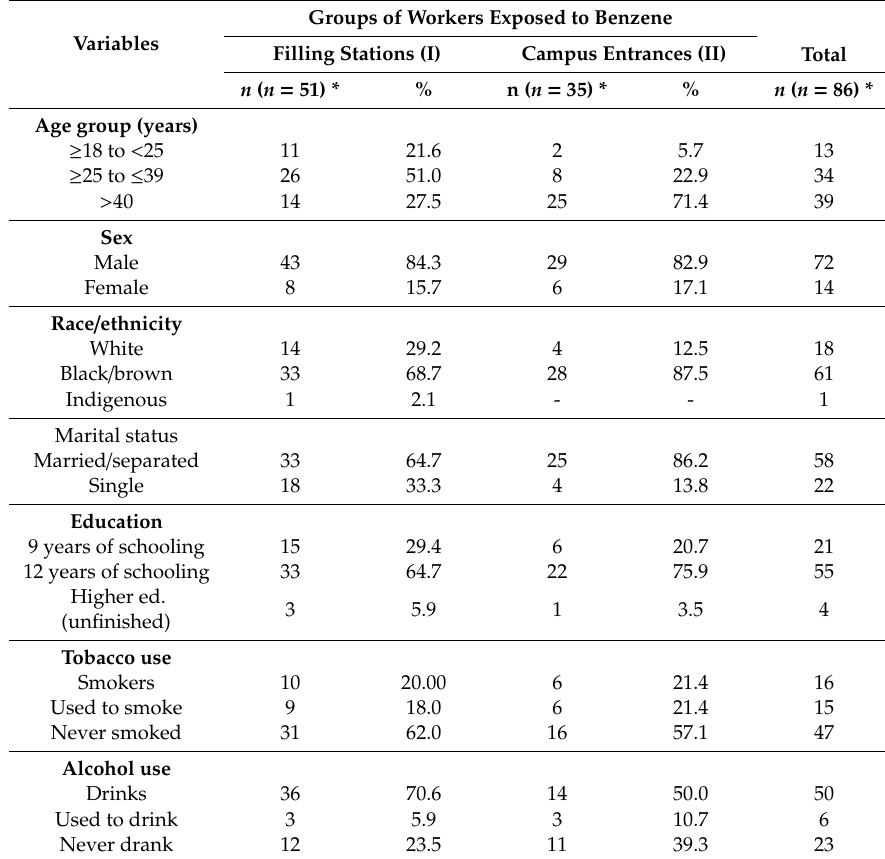
Table 1. Sociodemographic variables and risk factors of the two groups of workers exposed to low concentrations of